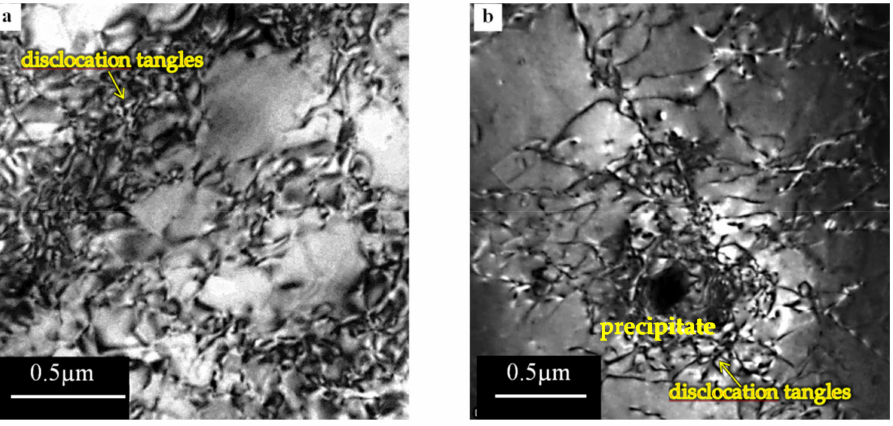
Figure 10. TEM microstructure of the base aluminum alloy: ( a ) dislocations are not uniform dis- tributed, ( b ) dislocation tangles blocked at the large precipitate.